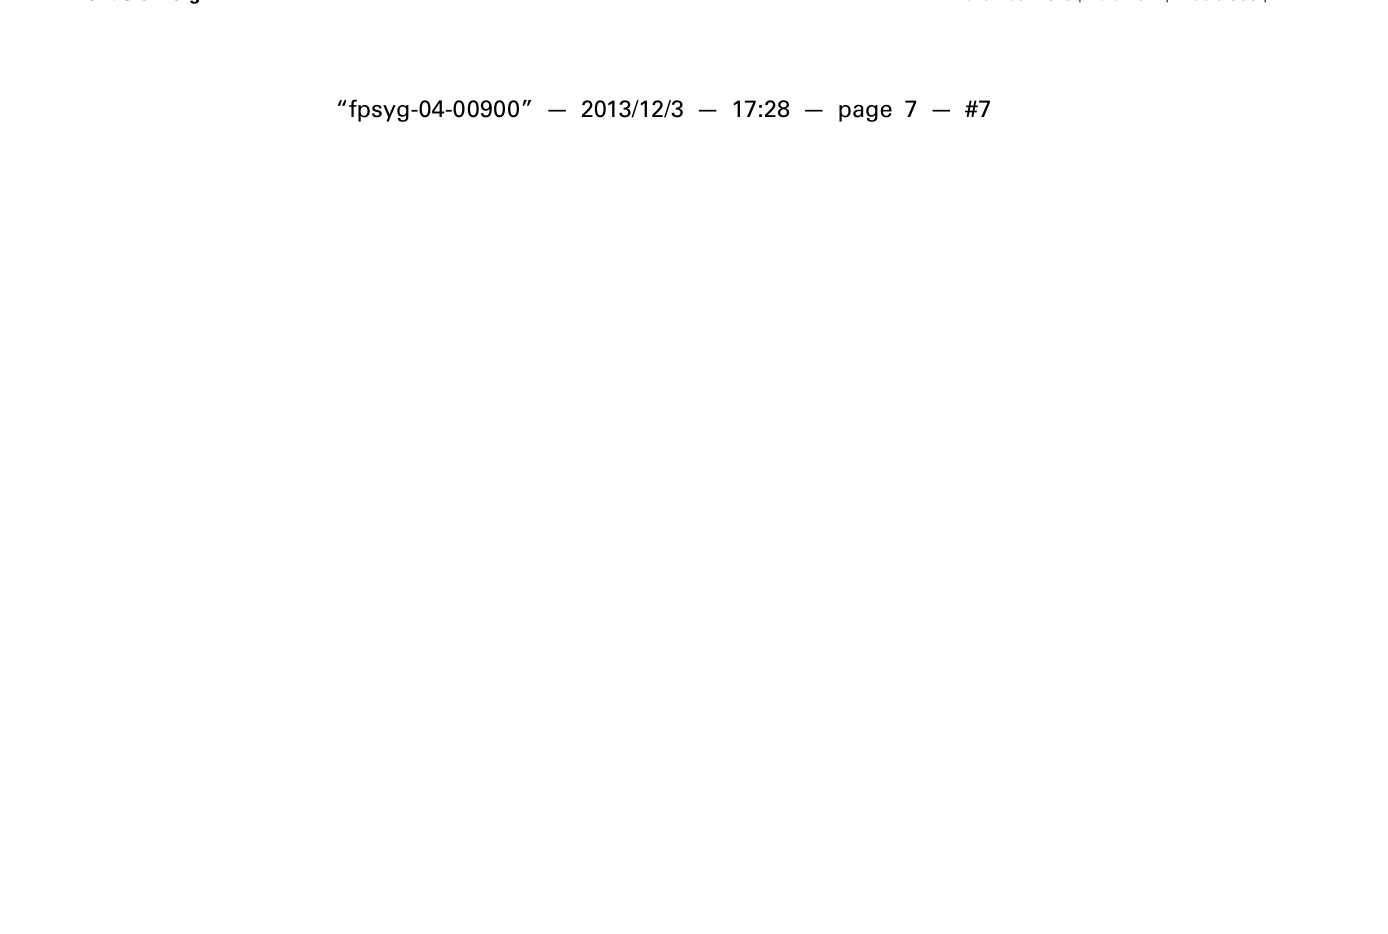
FIGURE 2 | Relationships between content variables. Relationships between content variables were averaged across 76 participants. For scales corresponding to each content variable, see Figure 1 and Table 1 . Note that